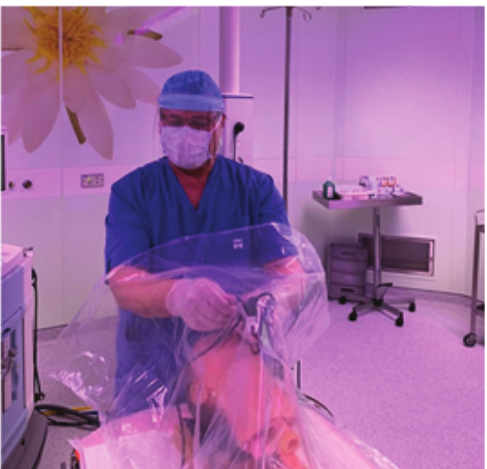
Figure 3: Combined intubation with glidescope and covering the patient chest and head with transparent plastic sheet for double